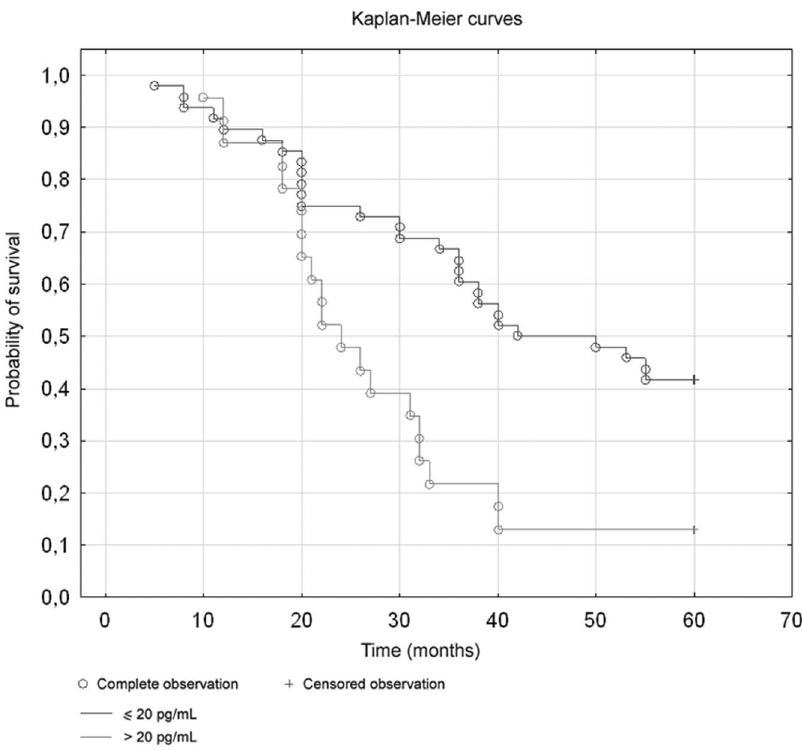
Figure 3. Survival curves in relation to inhibin B levels (p=0,00625, log-rank test).